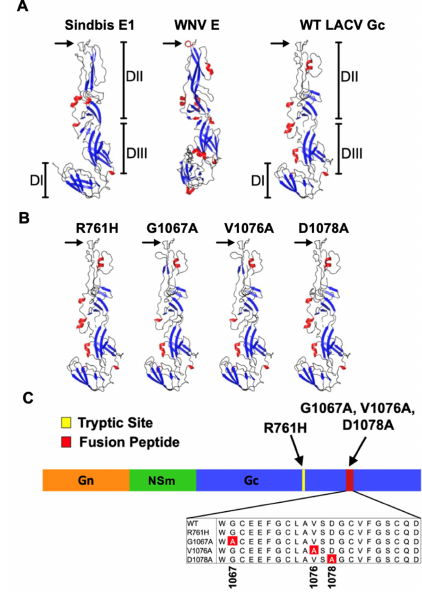
Figure 1. Structural models of WT-LACV Gc compared to other viral class II fusion glycoproteins, including Sindbis virus E1 and West Nile virus E based on SFV E1 as the canonical structure using Phyre2 and visualized with MacPyMOL. West Nile virus (WNV) E was included as reference. Struc- tural models demonstrate secondary structure as ß-strands (blue), α -helices (red), and (hydropho- bic) loops (gray). The fusion loop of each glycoprotein is labeled with a black arrow. Domain I (DI) is a ß-barrel with two long extensions connecting adjacent ß-strands. Domain II (DII) contains the highly conserved fusion peptide loop at its tip (black arrows) connecting the c and d ß-strands of DII. ( A ) Flexible hinge region is located between DI and DII. Domain III (DIII) is a stem region con- necting the fusion protein to the transmembrane anchor. In the post fusion hairpin structure, DIII and the fusion loop are brought into close proximity. ( B ) Structural models predict that the muta- tions in fusion peptide of LACV Gc do not alter the structure of Gc or the fusion loop. ( C ) Schematic representing the locations of the mutations within Gc and within the highly conserved fusion pep- tide.